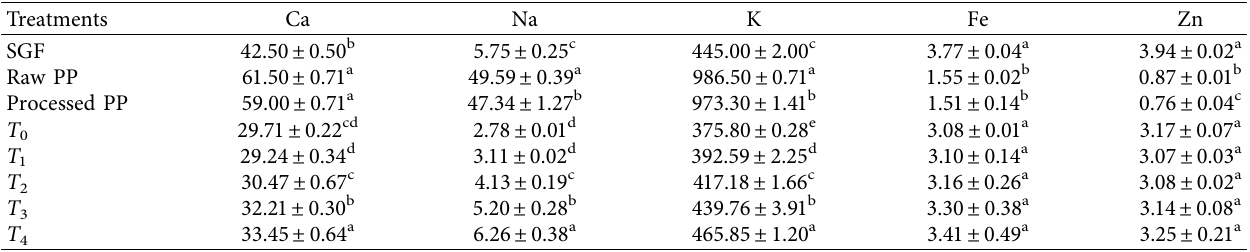
Values are means ± S.D. ( n � 2). Values having identical lettering in each column are nonsignificant at p > 0 . 05. T 0 � 100% straight-grade wheat flour chapatis (control), T Table 3: Antinutrient contents of straight-grade flour, raw and processed potato powder, and supplemented chapatis (mg/100g). Treatments Alkaloids Oxalates SGF Raw PP Processed PP T 1